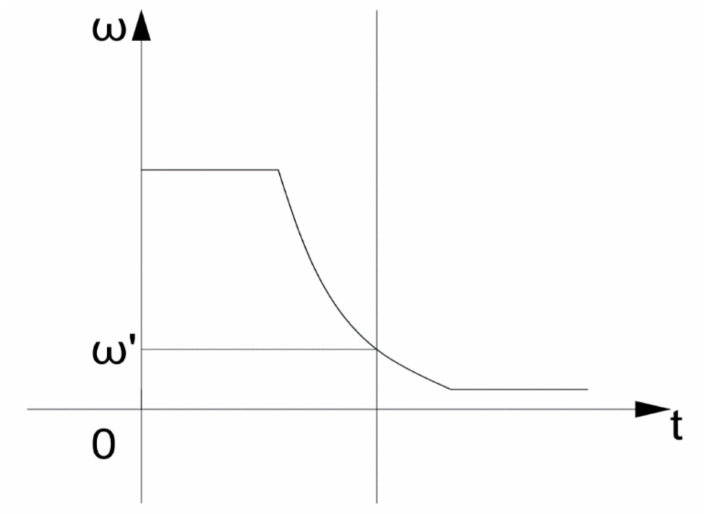
Figure 4. Speed graph for preventive shutdown. Provided there is no self-inhibition on Section 1, it is possible to make a cutoff at speed: ω ”. The graph is shown in Figure